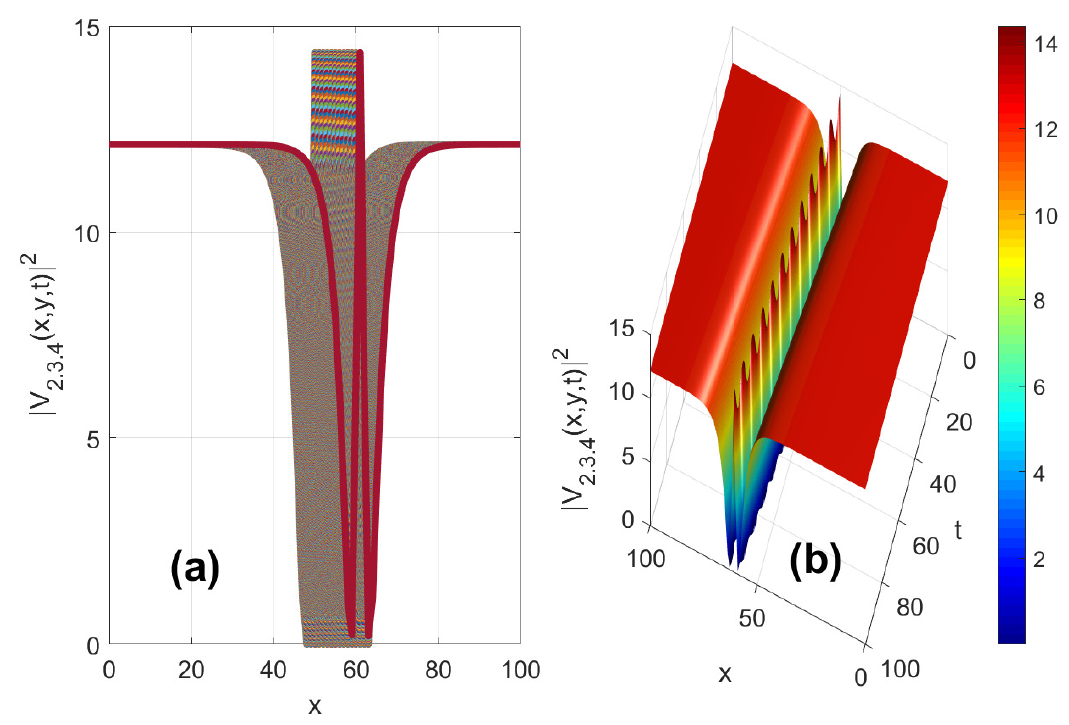
Figure 6. W-SS with the effects of the NELT parameters. ( a , b ) are, respectively, the 2D and 3D W-SP. The parameters used are p = q = 1, ϑ 0 = 0.1, y = 0, B 0 = − 0.02, B 1 = 0.1, B 2 = − 4.02, λ 2 = − 0.5,